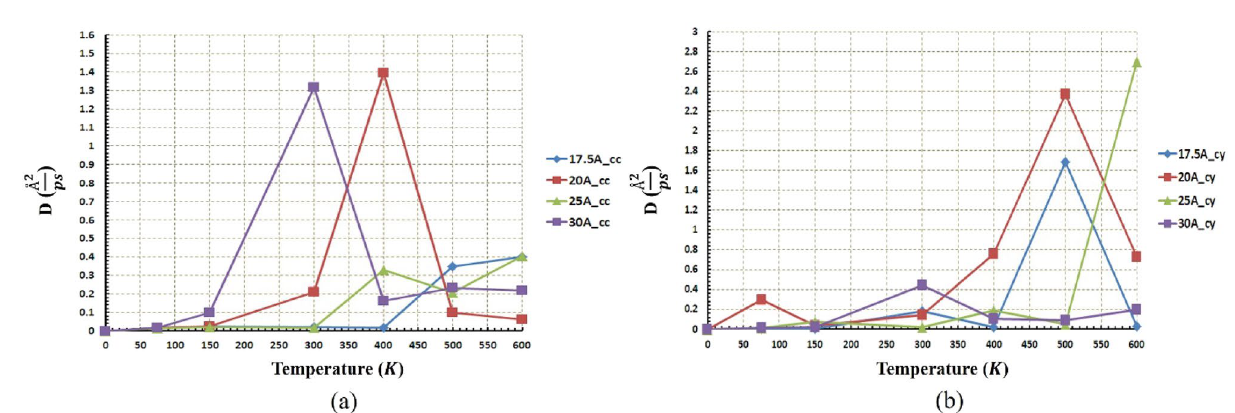
Figure 8. The Maximum potential energy of C60 at different temperatures and radii ( a ) for the concave (cc) gold substrates and ( b ) for the cylindrical (cy) gold substrates. The temperature does not affect the maximum potential energy for both geometries. In cylindrical geometry, the molecule’s maximum energy is double lower than the concave geometry.